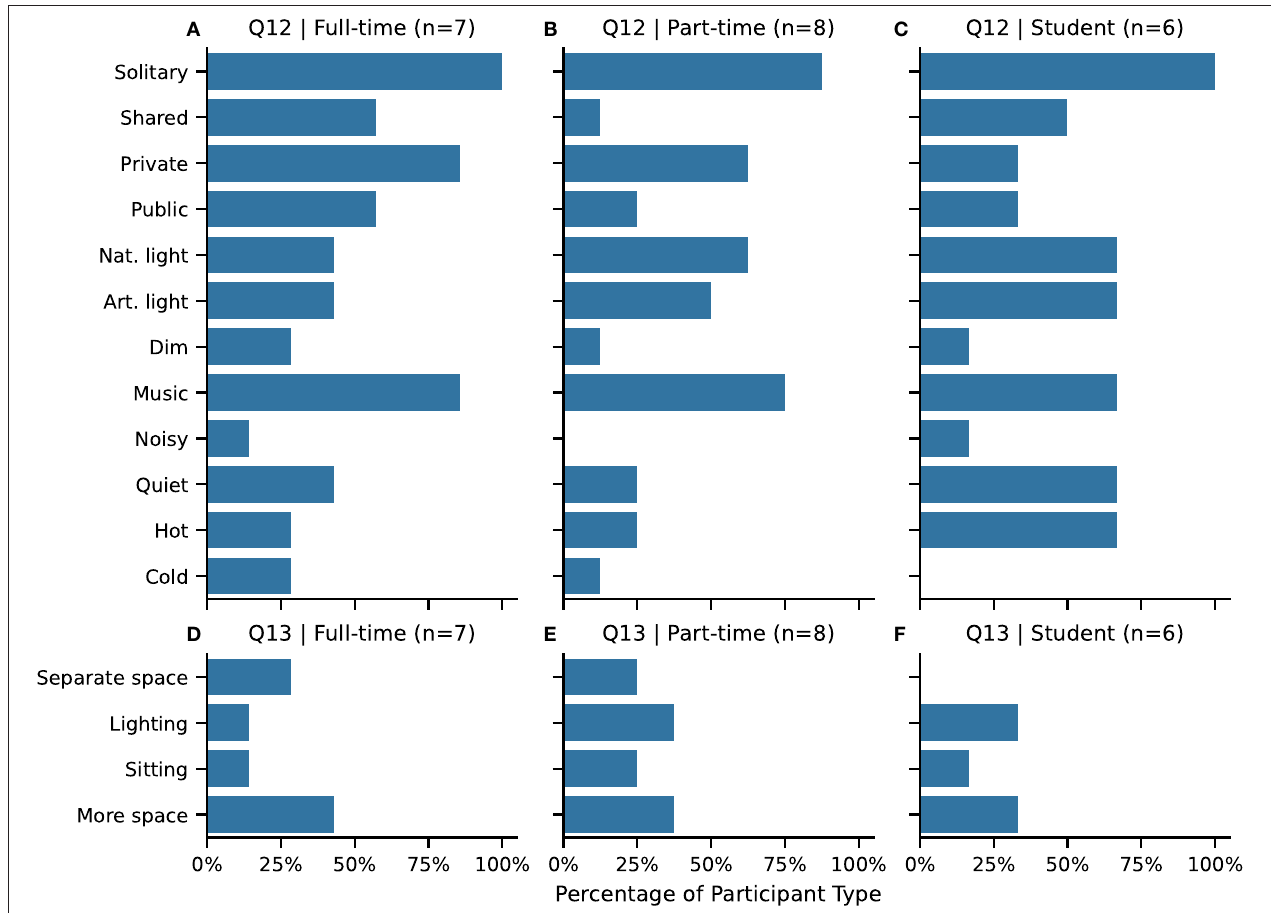
FIGURE 5 | (A–C) Q12. Characteristics of work environment: solitary work environment, shared work space, private setting, public setting, nat urally bright environment, art ificial bright environment, dim ly lit environment, listening to music , noisy environment, quiet environment, hot (temperature) environment, cold (temperature) environment. (D–F) Q13. Improvements to the work environment (annotated from the Q13 free responses shown in Table 3 ): dedicated or separate studio space, improved lighting , improved sitting , more space or table space. Abbreviations are in bold . Participants selected any combination of